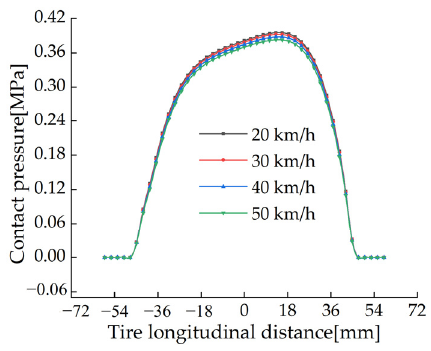
Figure 19. Contact pressure distribution of tire longitudinal contact patch at different speeds.